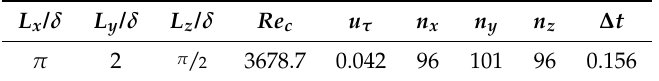
Table 3. Re τ = 200 turbulent channel flow: database